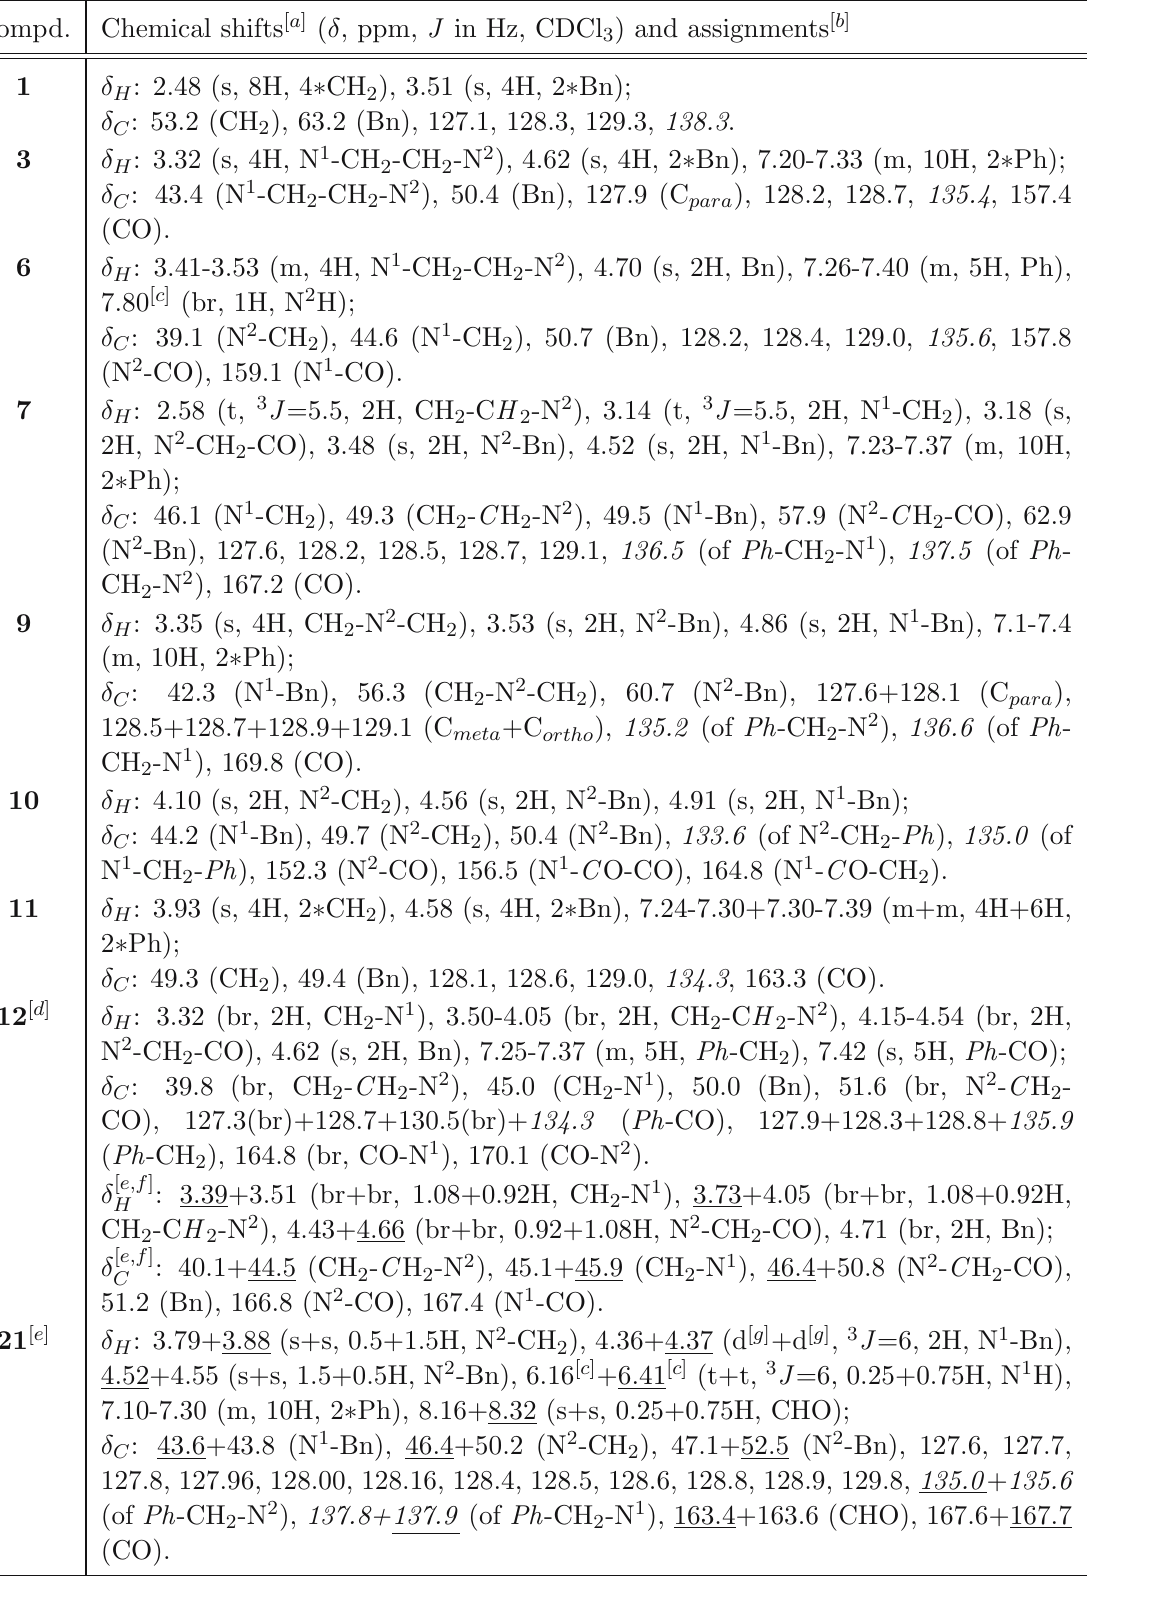
Table 2 1 H- and 13 C-NMR data of some compounds of